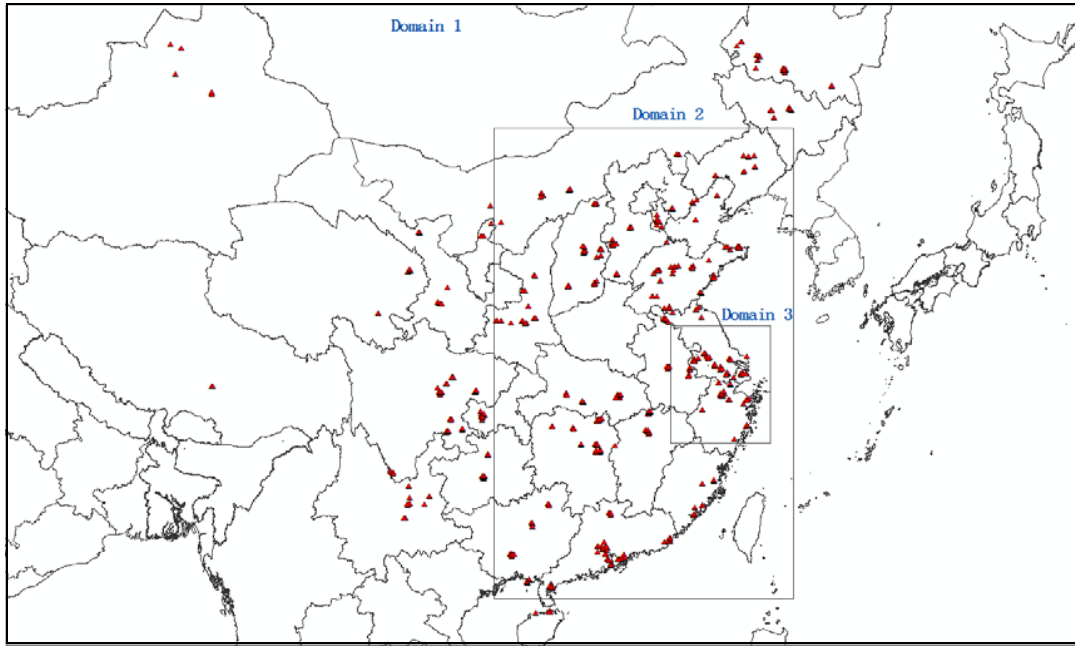
Fig. 1. Modeling domains and locations of the monitoring sites used for model evaluation. The red triangles indicate the 546 monitoring sites associated with the Ministry of Environmental Protection of China. Fig.1. Modeling domains and location of the monitoring sites used for model evaluation. The Table 1. The emissions of major pollutants for each domain during 28 April to 6 red triangles indicate the 546 monitoring sites from the Ministry of Environmental Protection